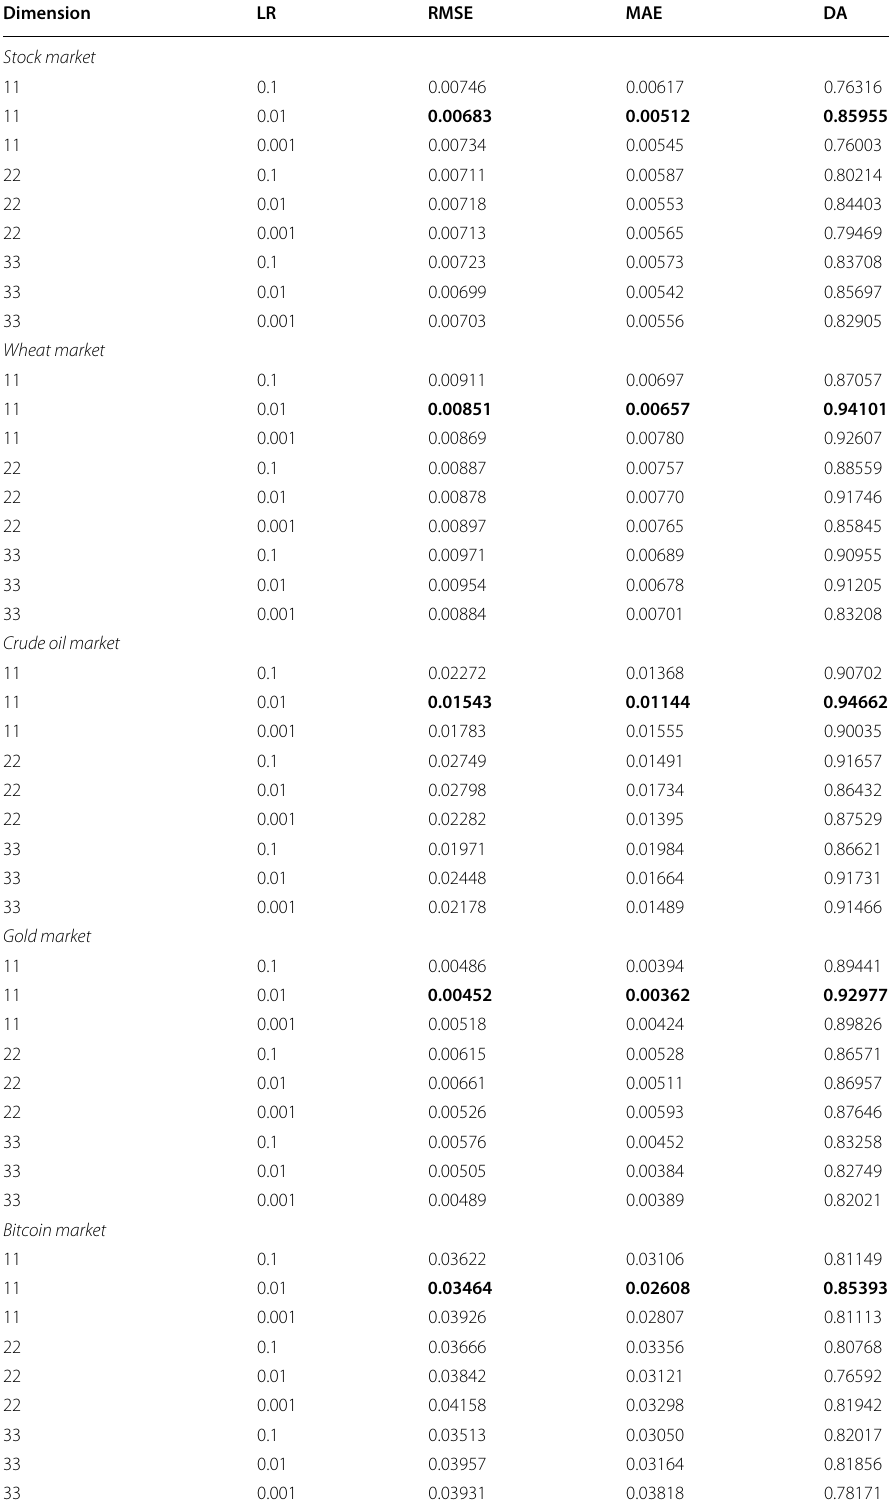
Table 3 Robustness test with different